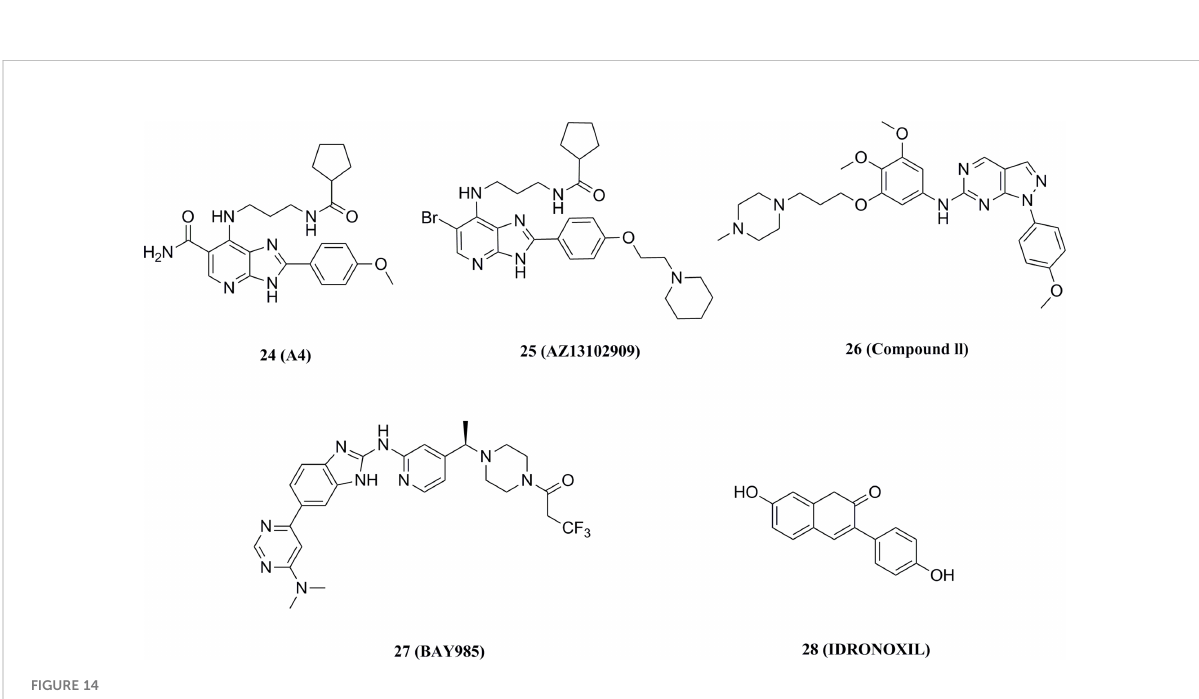
FIGURE 14 Other TBK1 small molecule inhibitors.